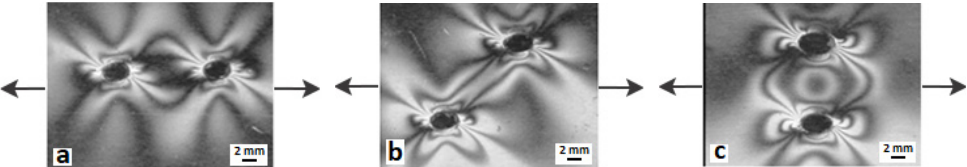
Figure 4. Fields of elastic stresses around holes in polyimide film with diameter d = 0.3 mm applied at different angles to the direction of tension; from left to right: ( а ) 90°, ( b ) 45°, and ( c ) 0°. Tensile stress was 15 MPa. The direction of the tensile stress is indicated by needles.